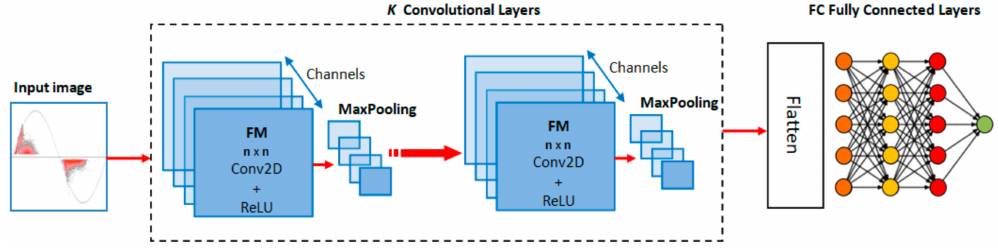
Figure 5. General architecture of a convolutional neural network. FC: fully connected